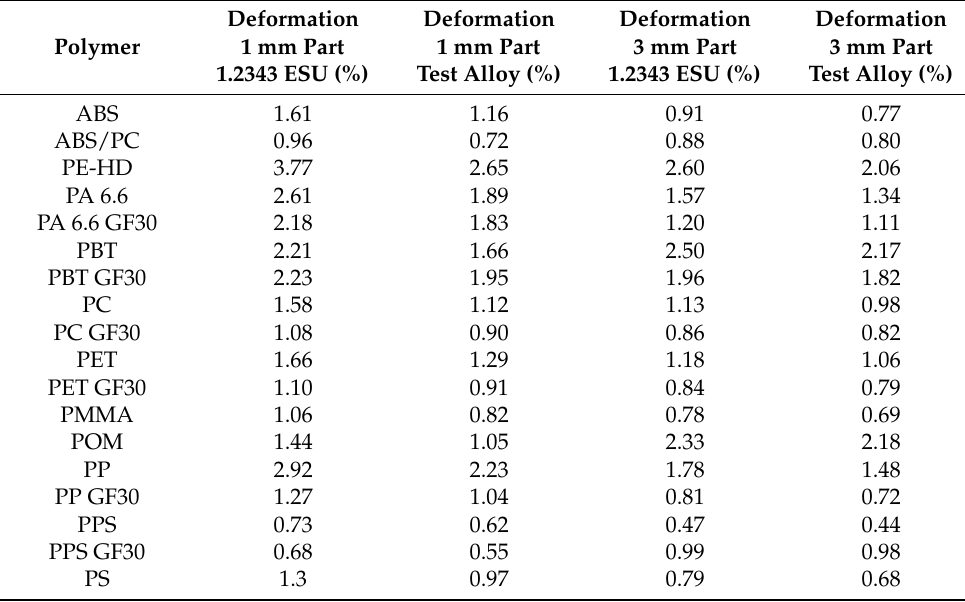
Table A4. Deformation results of the open side of the box for the investigated polymers for 1 mm and 3 mm part thickness for both mold